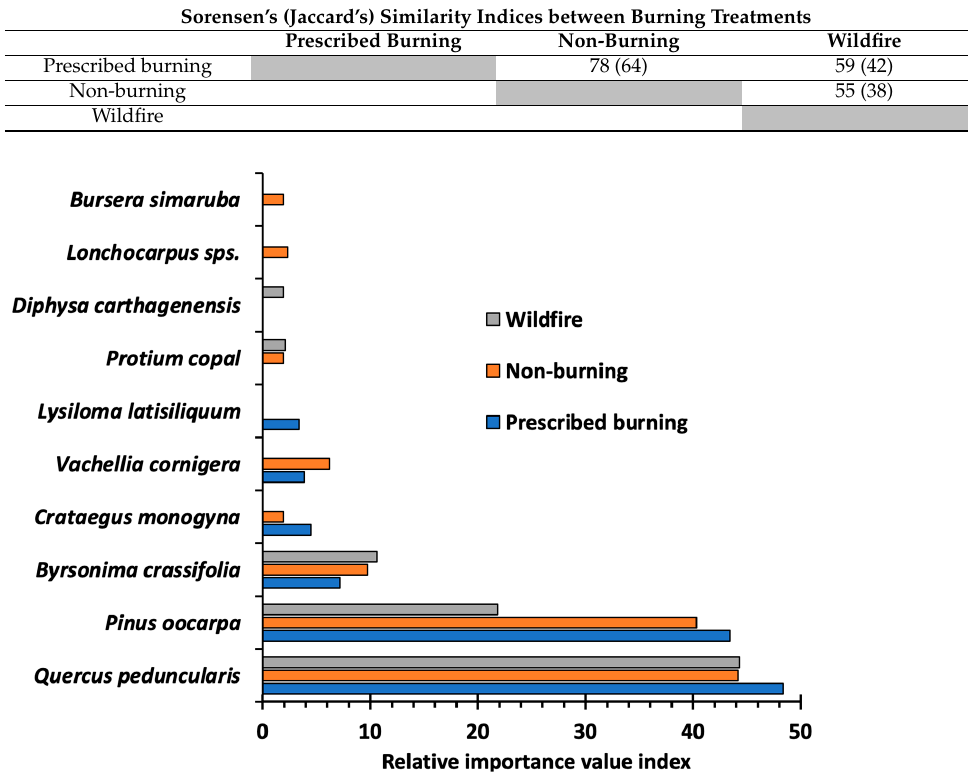
Table 2. Analysis of species composition similarity between sites with different burning types.